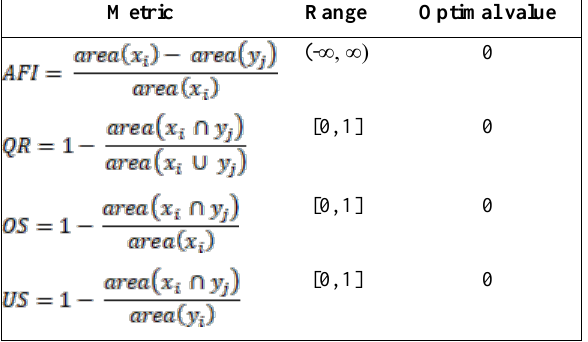
Table 1 . Metrics used to evaluate the segmentation accuracy. refers to reference polygons and